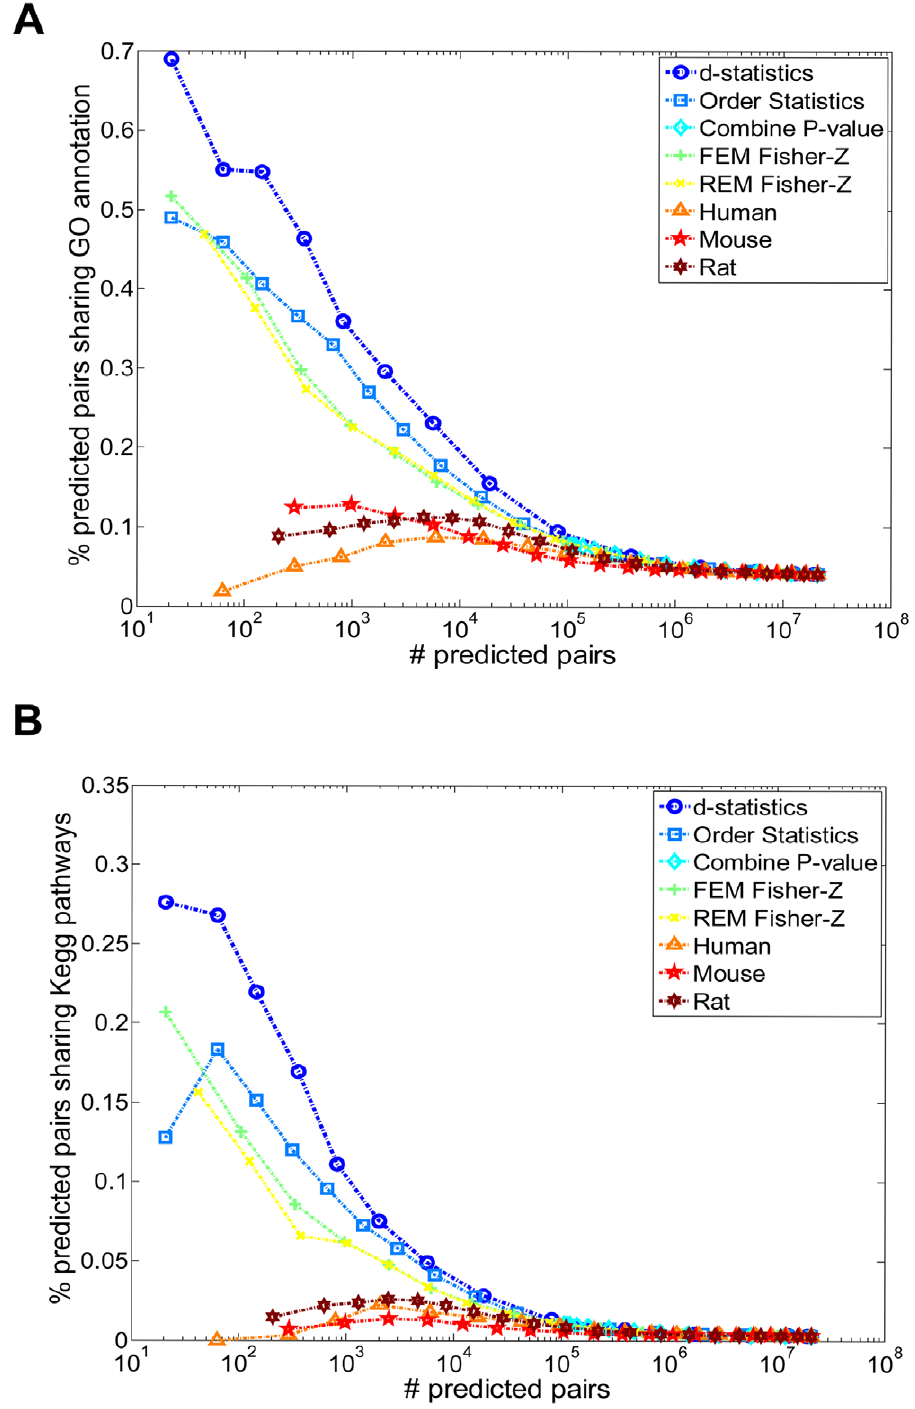
Figure 3. Performance comparison of the proposed method with existing meta-analysis methods, and with co-expression networks reconstructed using single species datasets (i.e. without evolution information), in identifying functionally coherent co-expression interactions. (A) Benchmarking using specific GO biological process categories. (B) Benchmarking using curated KEGG pathways. The abbreviations of different meta-analysis methods are the same as Figure 2. whether GWAS results associate with entire networks of genes, we Blood lipid concentration regulation is a complex process, overlapped blood lipid concentration results from the Framing- involving many different cellular pathways. We have recently ham heart study [26] and the Broad Institute lipid study [27] with demonstrated that common variation of complex traits is caused the human, mouse and rat conserved liver network. In this by networks of genes as opposed to single genes [4]. To assess